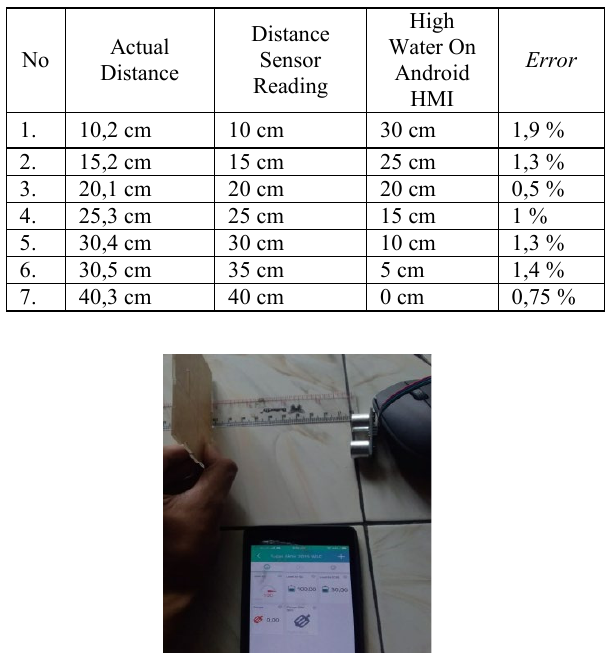
Table 1. Test Results of 30 cm Setpoint Ultrasonic